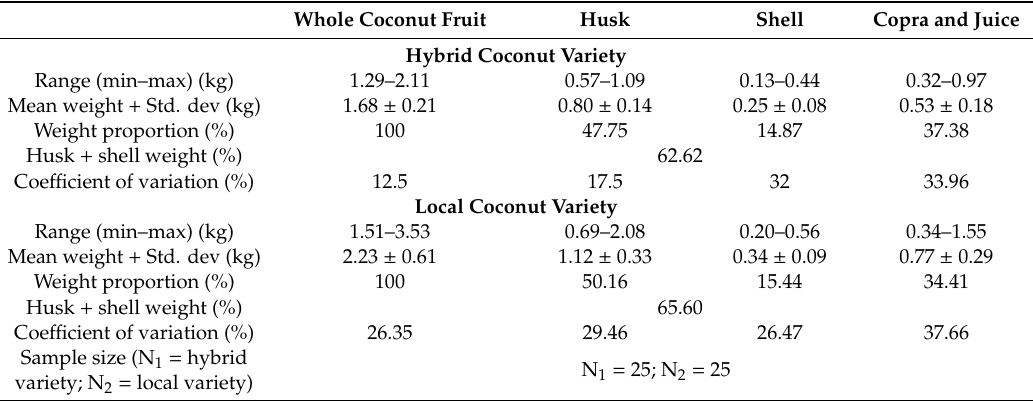
Table 1. Measured values on weight of whole coconut, husks, shells and copra / juice of hybrid and local coconut varieties.